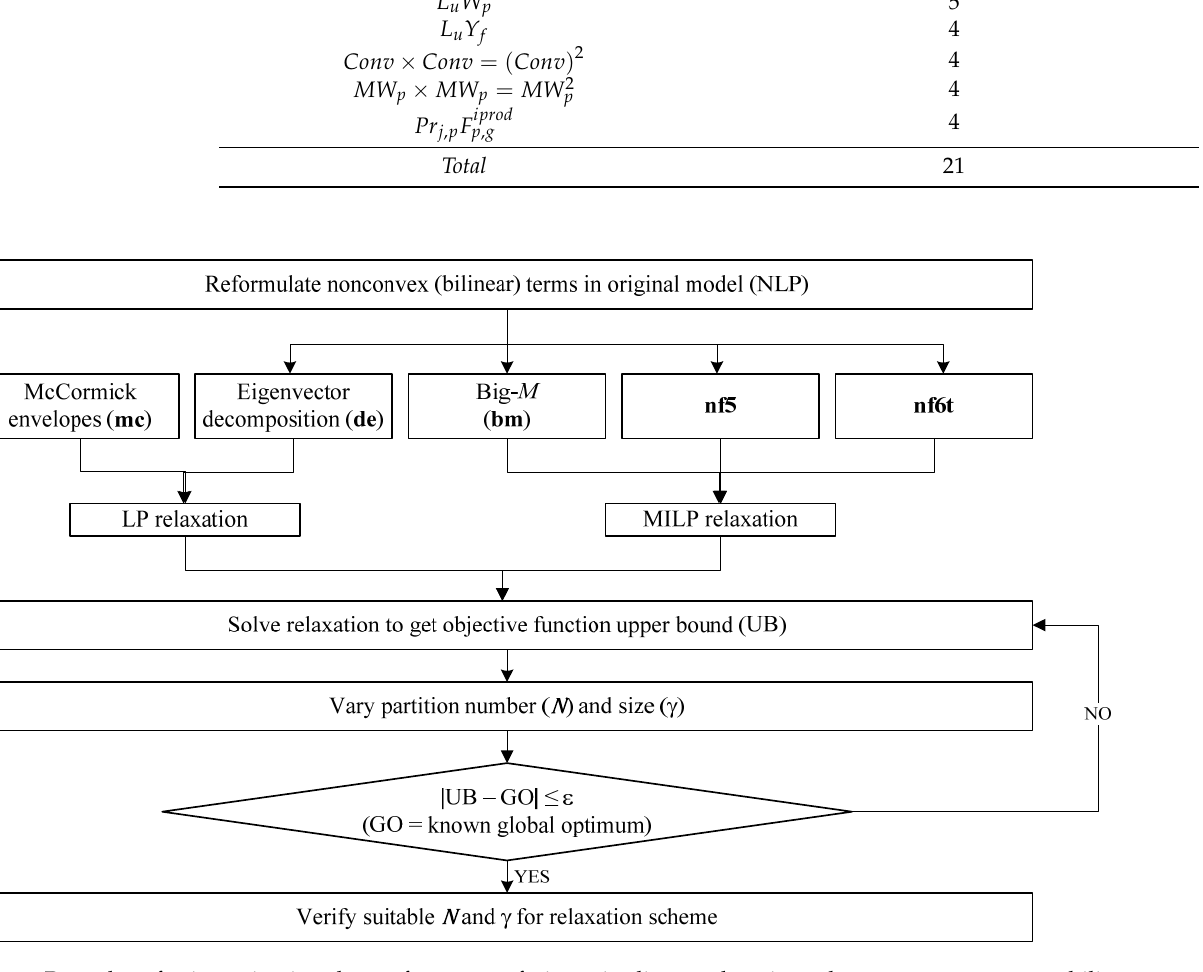
Figure 3. Procedure for investigating the performance of piecewise linear relaxation schemes on a nonconvex bilinear refinery planning NLP model.